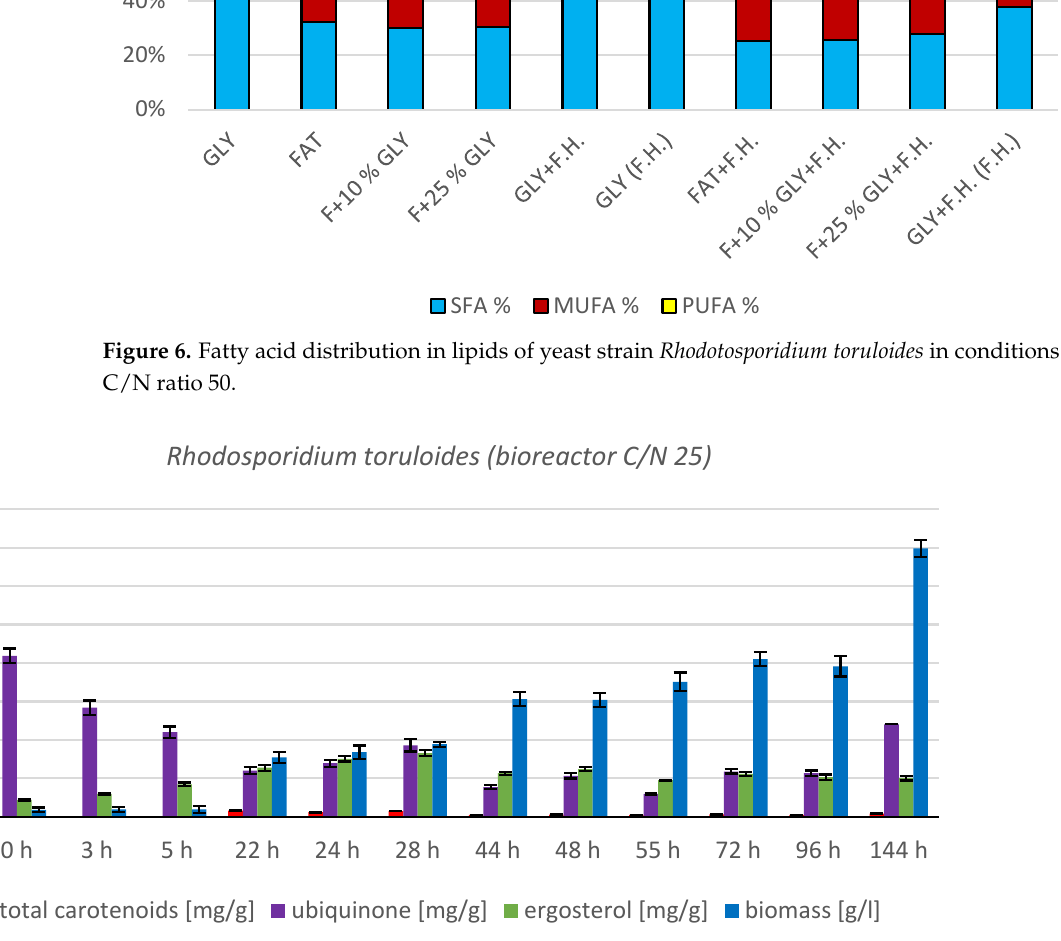
Figure 7. Metabolite production by biomass of yeast strain Rhodotosporidium toruloides in conditions of C/N ratio 25 cultivated in bioreactor.